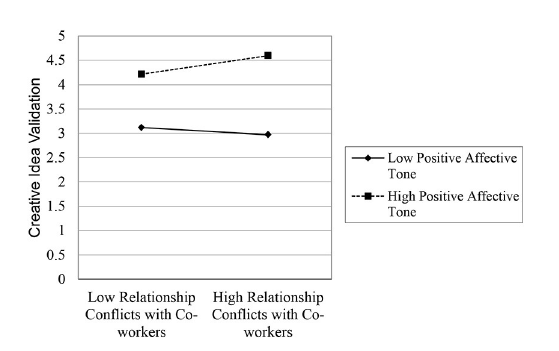
FIGURE3 Plot of interaction between relationship conflict with co-workers and positive affective tone.